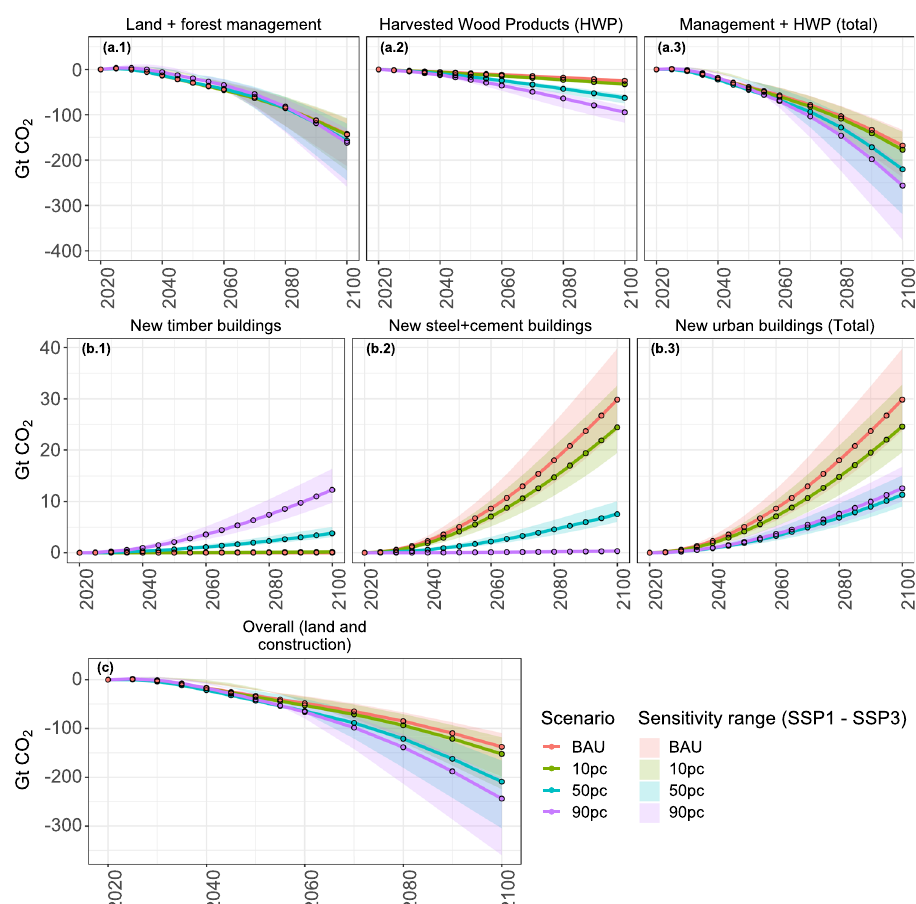
Fig. 3 | Comparison of global cumulative emissions from land use and con- struction material manufacturing by 2100 (with respect to 2020). Solid lines represent emissions in engineered wood demand scenarios in an SSP2 world. The transparent area shows the emission range between SSP1 and SSP3 scenario. a.1 Emission from land and forest management (calculated as the sum of gross land- use change emissions and regrowth emissions from forests 11 , see Supplementary Fig.9). a.2 long-termcarbonstorageinharvestedwoodproducts(calculatedasthe sum of carbon storage in industrial roundwood and buildings made out